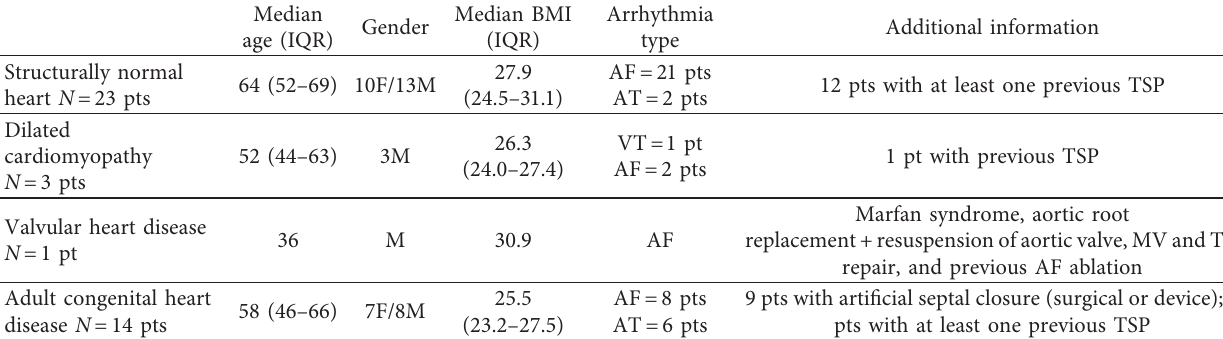
Table 1: Patient demographics